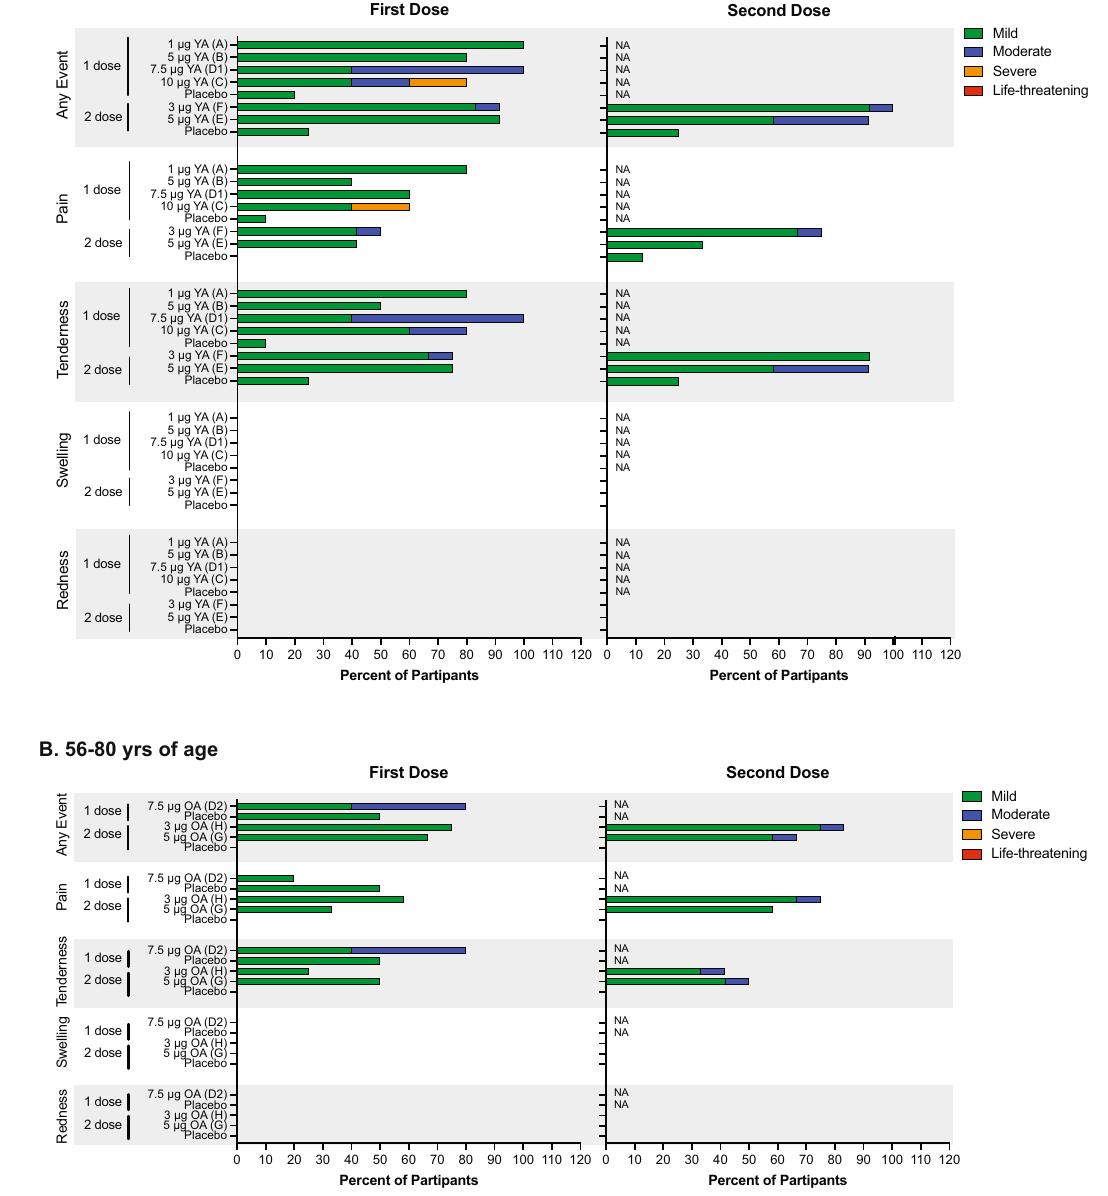
Fig. 2 Local solicited adverse events. Shown are the percentages of vaccinated participants reporting local solicited events. Data are represented for age groups, 21 – 55 years ( A ) and 56 – 80 years ( B ). Severity of local solicited Events are displayed as mild (green), moderate (blue), severe (orange), or life-threatening (red). *Note, injection-site swelling and injection-site redness were not reported. YA younger adults (21 – 55), OA older adults (56 –